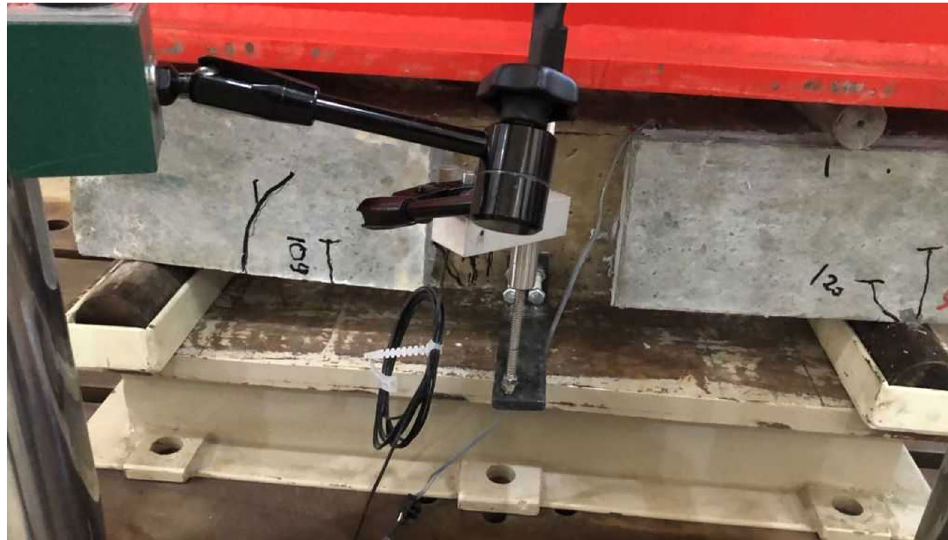
Fig. 14 RC beam shear-reinforced and strengthened with HPFRC